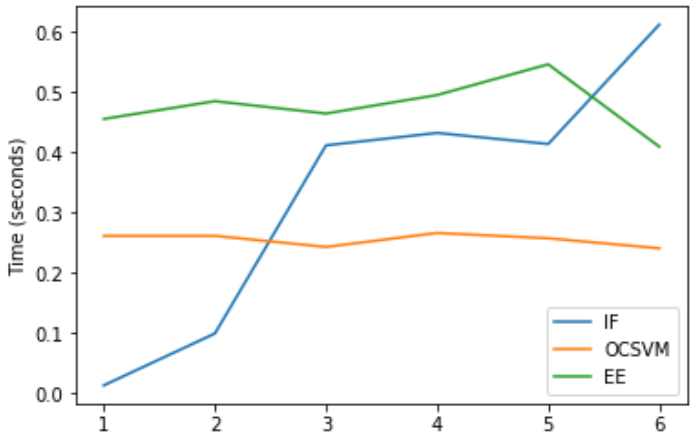
Figure 6. Average execution times for each model specific hyperparameter. The values on the x -axis correspond to the case numbers in Table